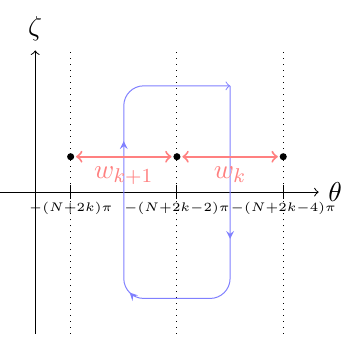
Figure 4 . Monodromy around a point at a phase